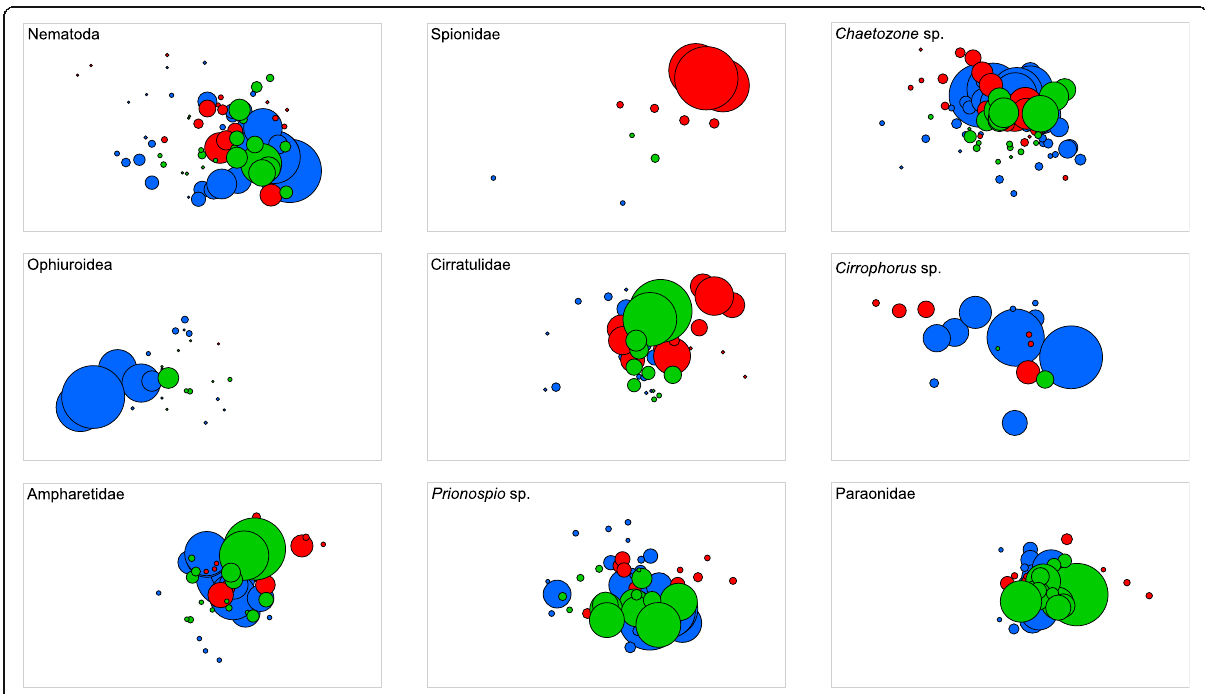
Fig. 6 n MDS of benthic macrofauna abundance obtained by untransformed Bray-Curtis index. The species that contributed most to the differences among environments are superimposed by bubble plots of density obtained from SIMPER analysis. Mussels (blue), Salmon (red) and Reference (green). The size of the bubble indicates the magnitude of species abundance. Stress: